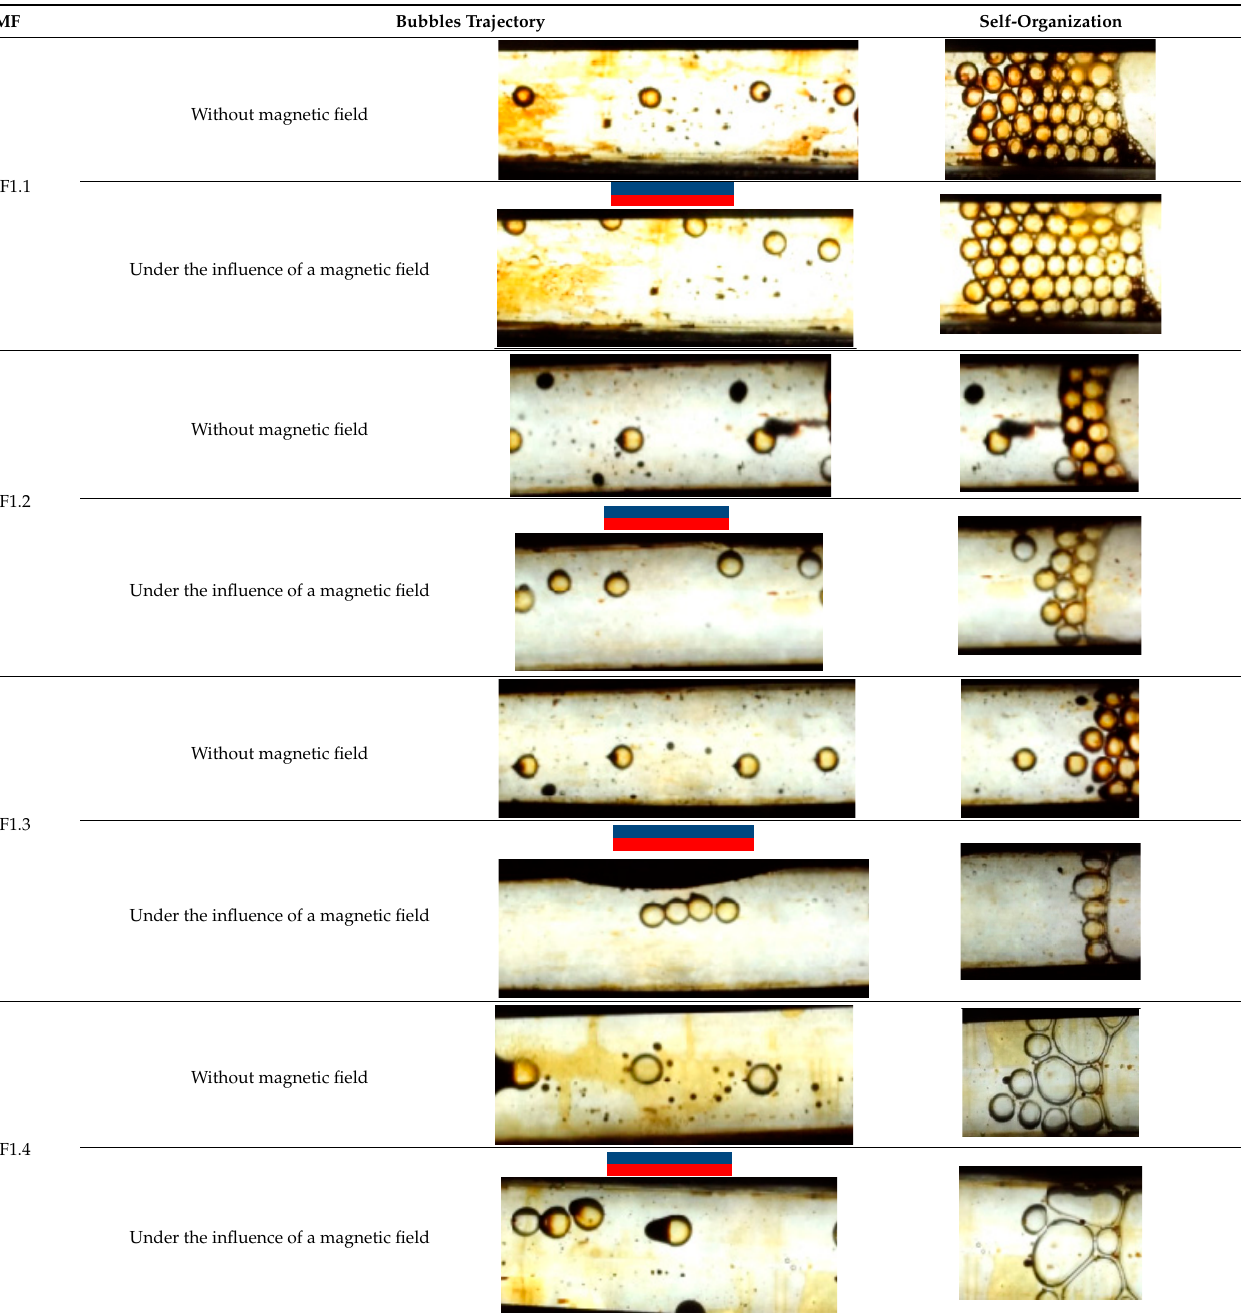
Table 5. Dynamics of active bubbles in the multiphase system MF-oil.